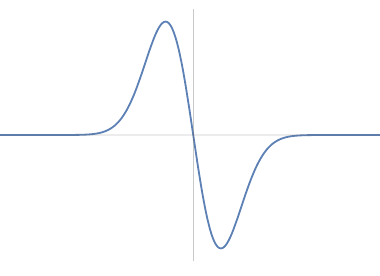
(b) Dipole profile centered around ω ˜ q = ω ˜ p , which converges to δ (1) ( ω ˜ q − ω ˜ p ) in the limit of zero width. Figure 2. Comparison of the expectation values of h ψ q , out | E scalar (ˆ n ) | ψ p , out i and h ψ q , out | K scalar (ˆ n ) | ψ p , out i as a function of the energy ω